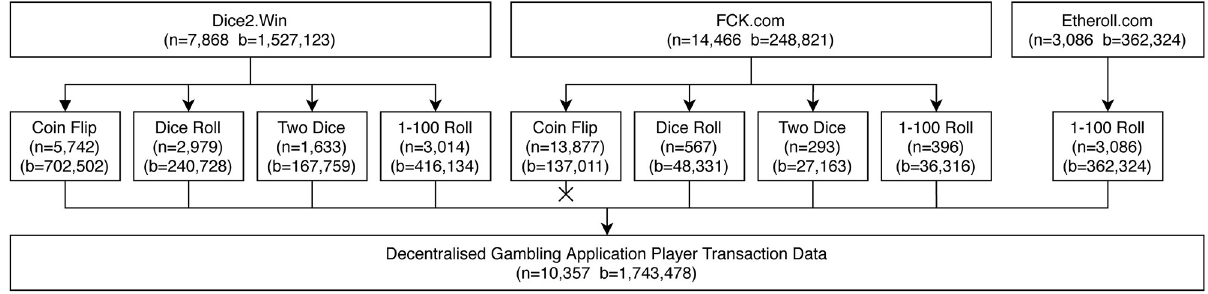
Fig 1. Provider-game combinations, including unique address and bet counts taken forward to the final player transaction set.